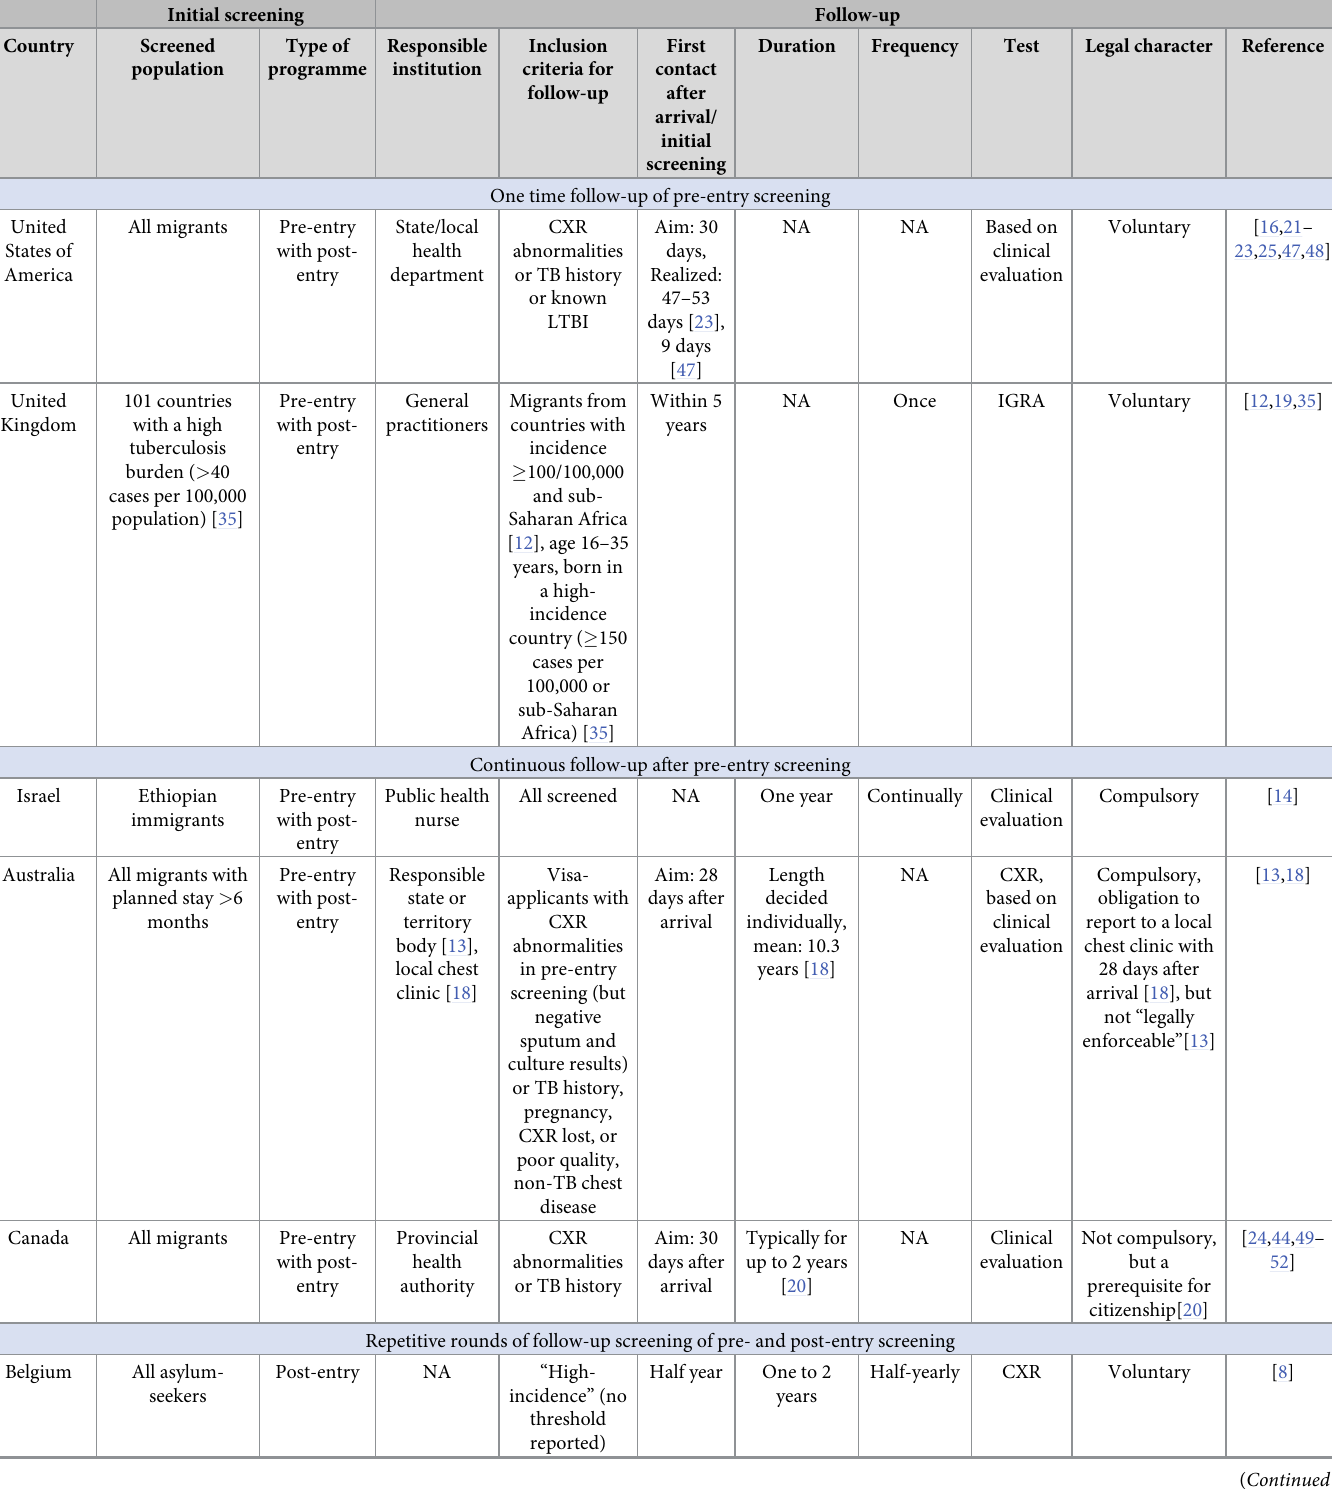
Table 1. Key characteristics and overall design of the identified post-migration follow-up screening programmes for tuberculosis and the respective initial screen- ing programmes. Initial